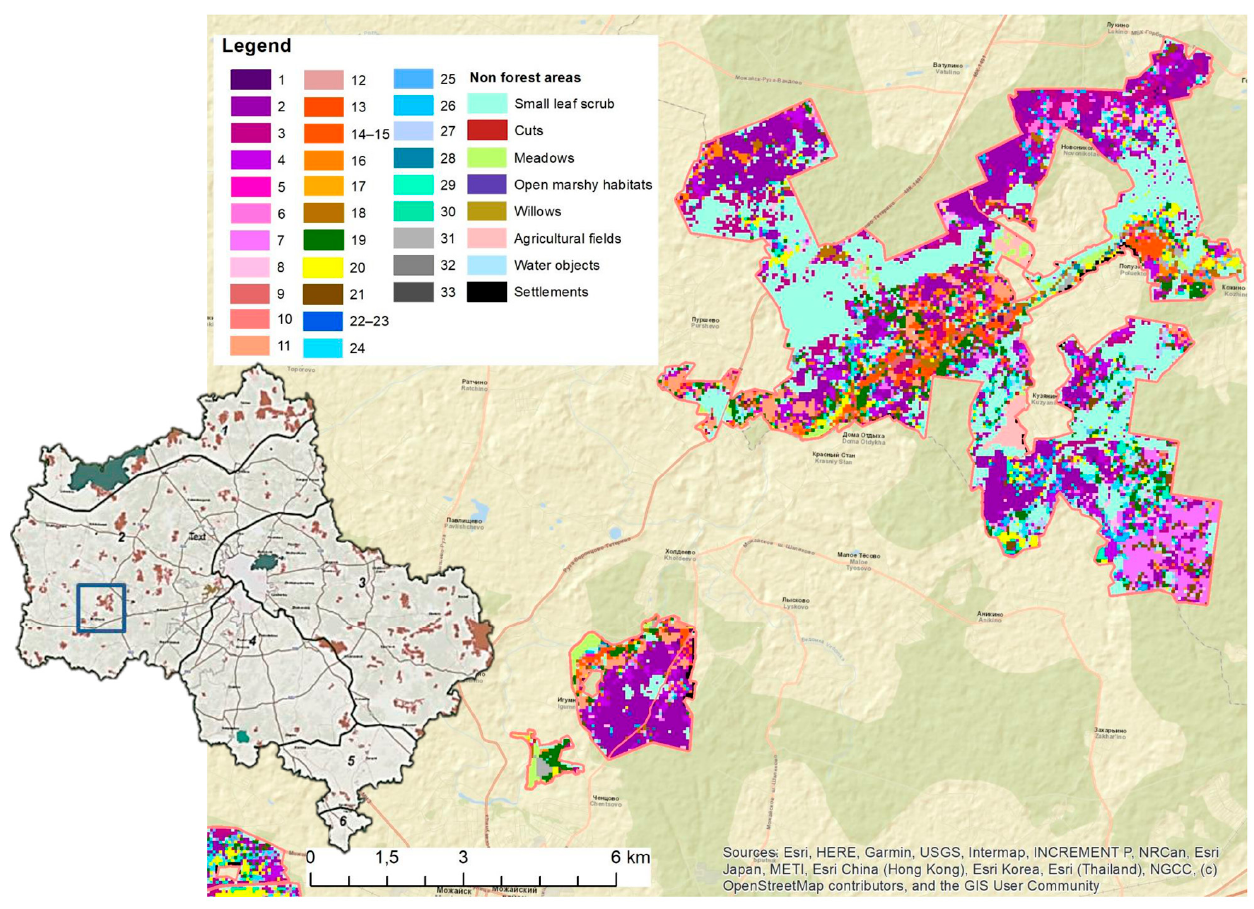
Figure 4. Fragment of the forest biodiversity map of PAs in the MR.